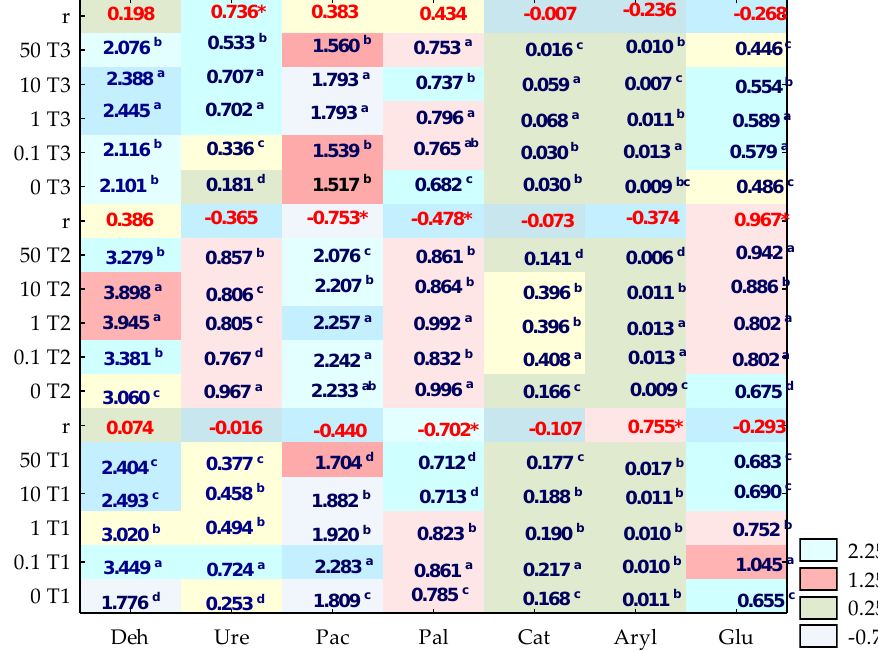
Figure 12. Enzymatic activity in soil contaminated with o-cresol on day 15, 30 and 45 of the experi- ment, (kg −1 DM of soil h −1 ); Deh—dehydrogenases (μMol TFF); Cat—catalase (Mol O 2 ); Ure—urease (mMol N-NH 4 ); Pal—alkaline phosphatase; Pac—acid phosphatase; Glu—β-glucosidase; Aryl—ar- ylsulfatase (mMol 4-nitrofenol PN). Homogeneous groups are specified in columns for each en- zyme, depending on the increasing doses of o -cresol during T1—15 days, T2—30 days, T3—45 days of the experiment and denoted with letters (a–d), r—Pearson’s linear correlation coefficient, * sig- nificant for p = 0.05, n = 14.